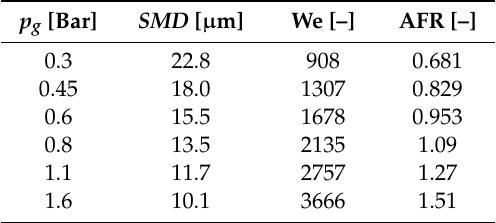
Table 5. Estimated properties of crude rapeseed oil atomization at various p g . p g